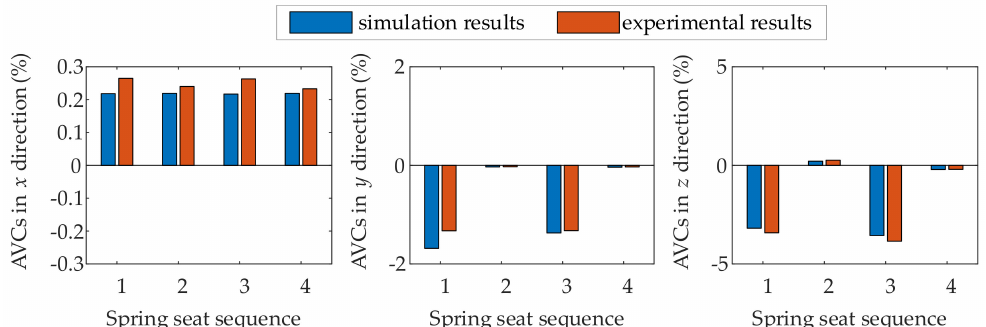
Figure 13. The amplitude variation coe ffi cients (AVCs) of each spring seat in the x , y , and z directions under spring failure kind 4, including the simulation results and experimental results.